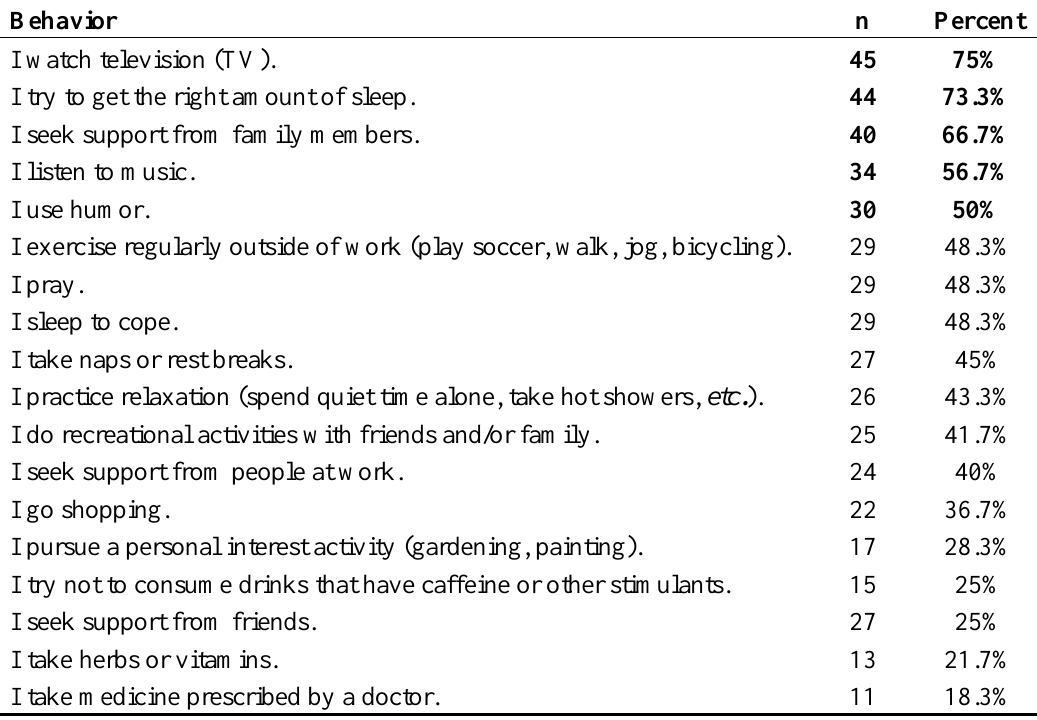
Table 2. Frequency of behaviors to cope with